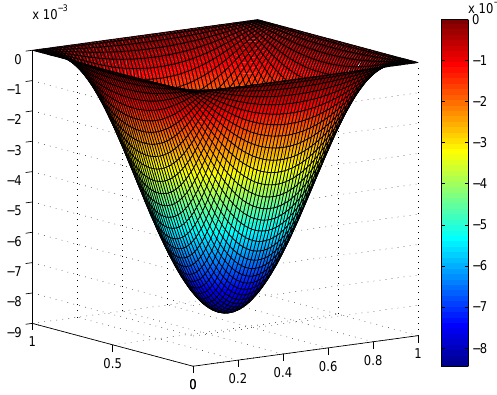
Figure 2. The numerical solution u h with κ = 10 3 .